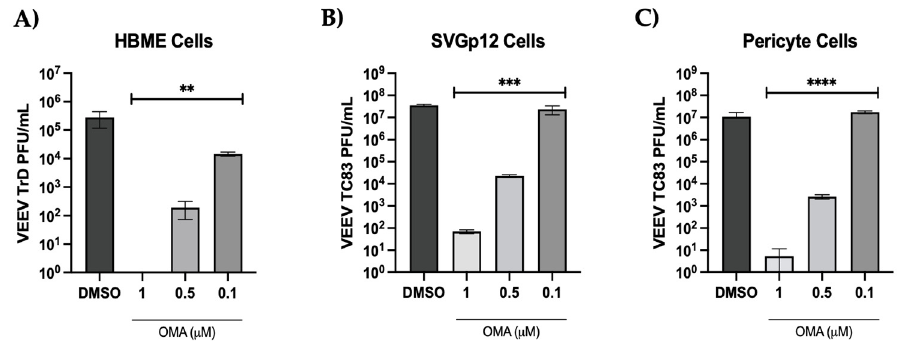
Figure 6. Dose–dependent inhibition of VEEV TrD in the endothelial cells, astrocytes and pericytes. Endothelial cells ( A ), astrocytes ( B ) and pericytes ( C ) were seeded in 96-well plates. The cells were pretreated with increasing concentrations of OMA for 1 h prior to infection. DMSO was maintained as the vehicle-alone control. The drug-containing media were removed and virus-containing media (TrD at MOI: 0.1) were added to the cells for 1 h to permit infection. The virus-containing medium was replaced with drug-containing media after 1 h and cells were maintained at 37 °C for 18